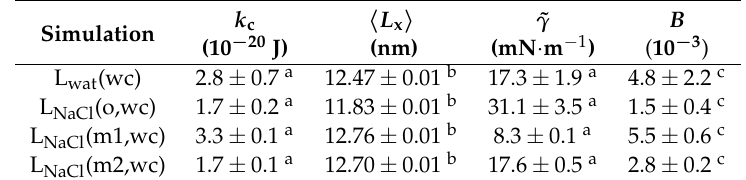
Table 5. Bending stiffness k c (Equation (18)) for simulations of large membrane patches in pure water or a NaCl solution described with the original or modified force-field versions. The average box-edge length along the (quadratic) membrane plane (cid:104) L x (cid:105) (= (cid:104) L y (cid:105) ) and the microscopic surface tension coefficient ˜ γ (Equation (18)) are also provided. The coefficient B (Equation (8)) characterizing the extent of membrane interdigitation was calculated using k c reported in this table along with the membrane thickness D HH and area compressibility κ A reported in Table 1 for the corresponding small systems S wat (pr), S NaCl (o,pr), S NaCl (m1,pr) and S NaCl (m2,pr). The simulation acronyms are explained